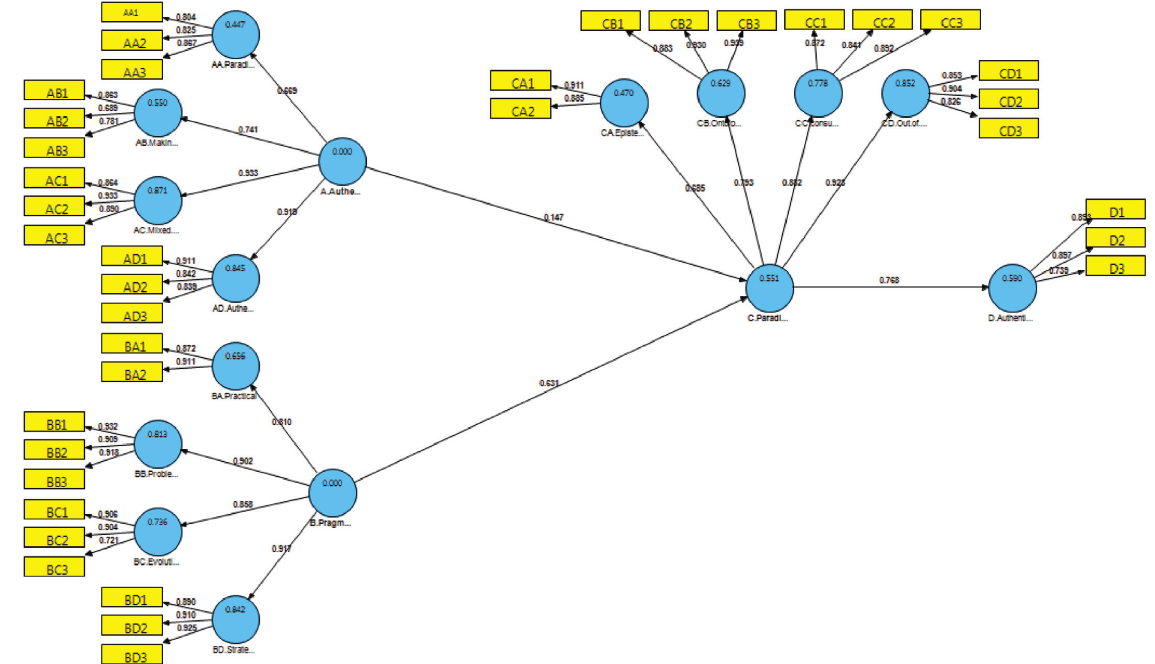
Figure 2: The external model of first-order hypothesis in the general standard state.